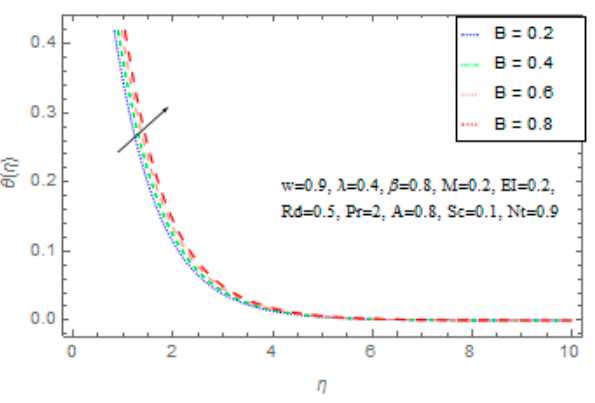
Figure 10. Influence of B on ( ) θ η Profile.